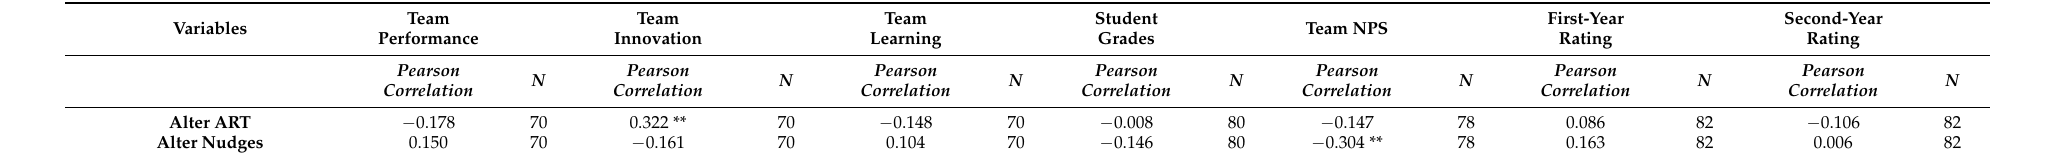
Table A2. Pearson Correlation between Personal/Moral Values and Job